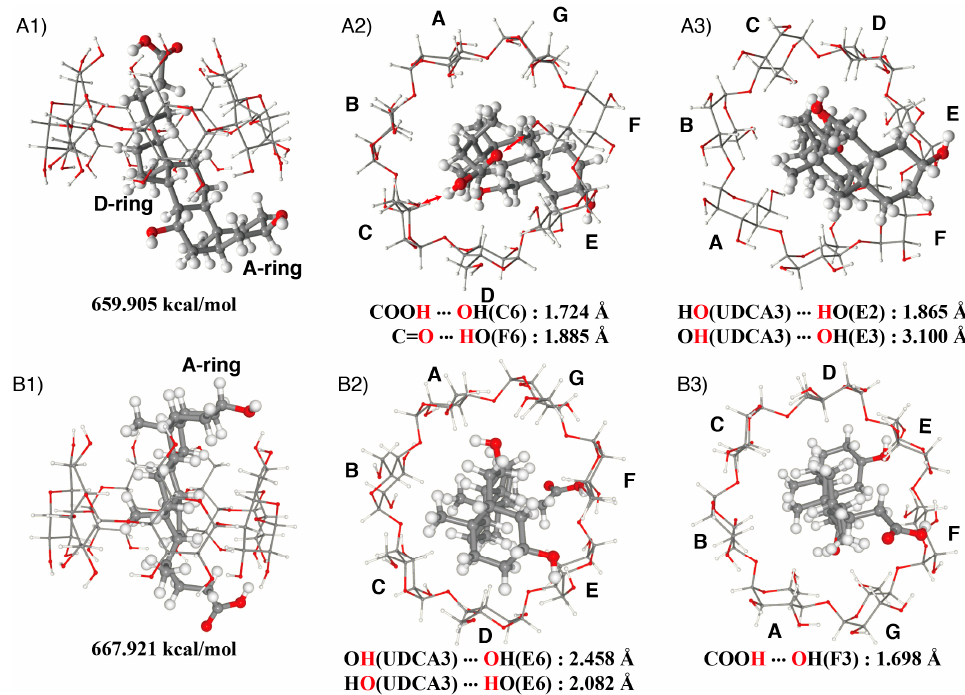
Figure 9. Estimated structure of the β -CD/ UDCA complex; ( A ) the UDCA enters on the side of the aliphatic side chain: ( A 1) side view, ( A 2) view from the primary hydroxy side, (A3) view from the secondary hydroxy side; ( B ) the UDCA enters on the side of the A-ring: ( B 1) side view, ( B 2) view from the primary hydroxy side, (B3) view from the secondary hydroxy side.